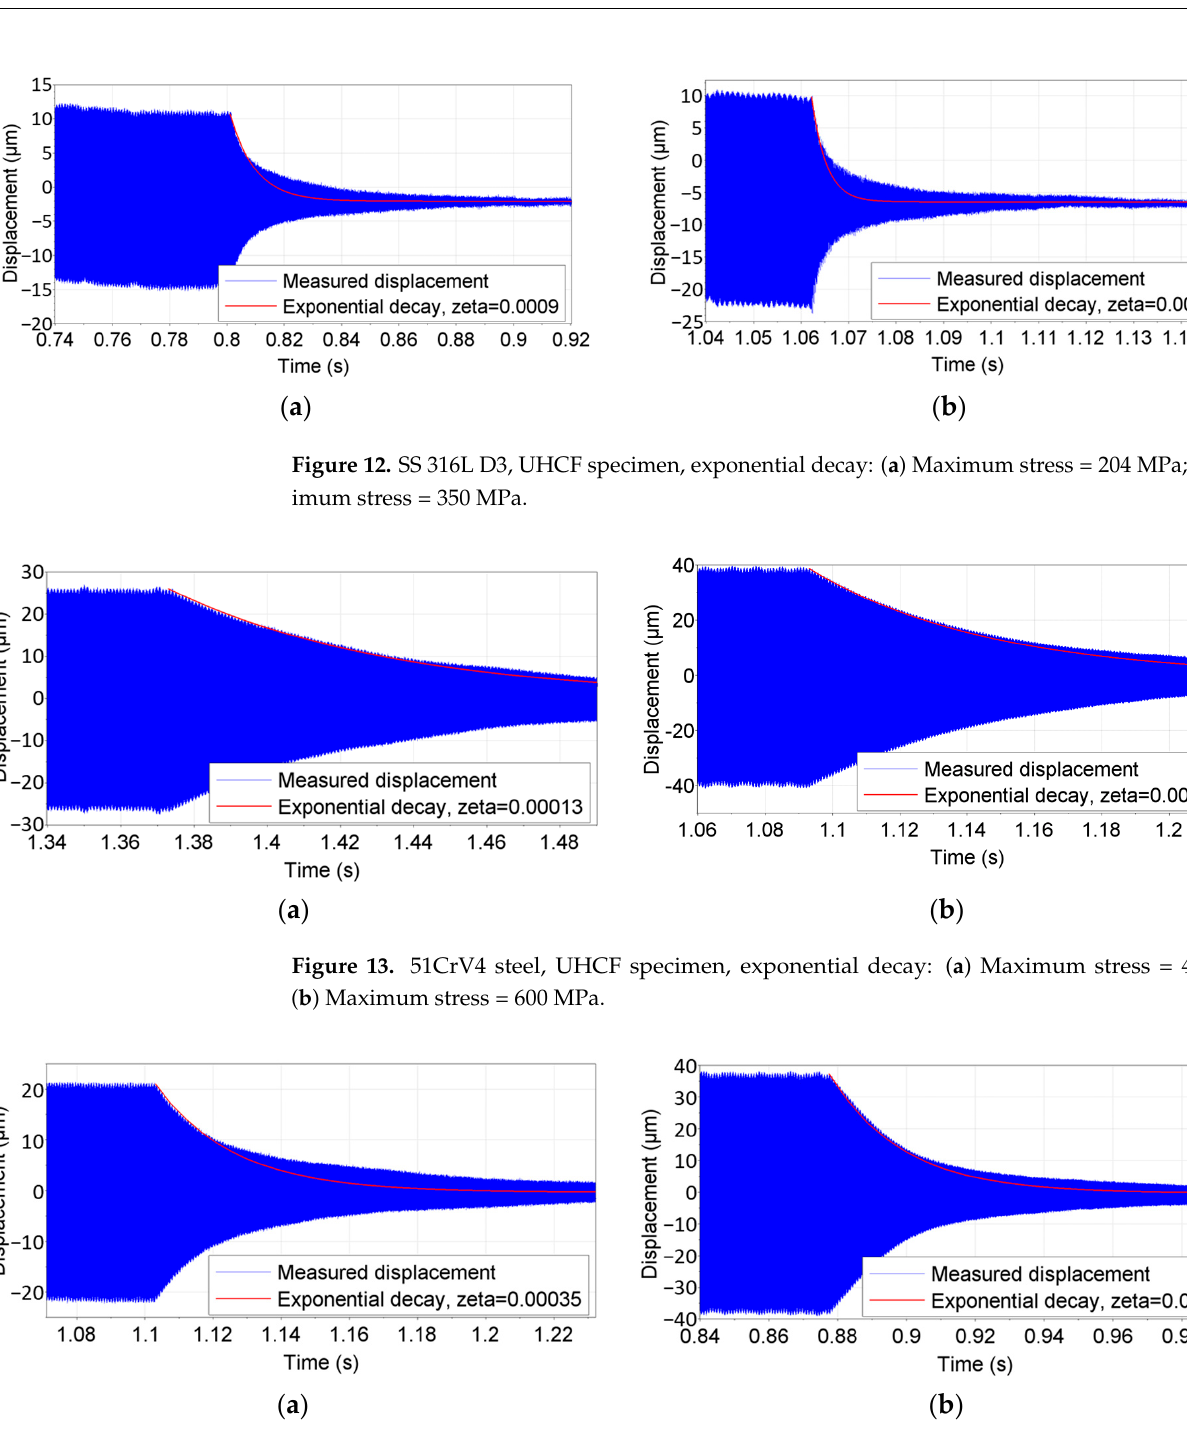
Figure 14. S690 steel, UHCF specimen, exponential decay: ( a ) Maximum stress = 220 MPa; ( b ) Maximum stress = 390 MPa.